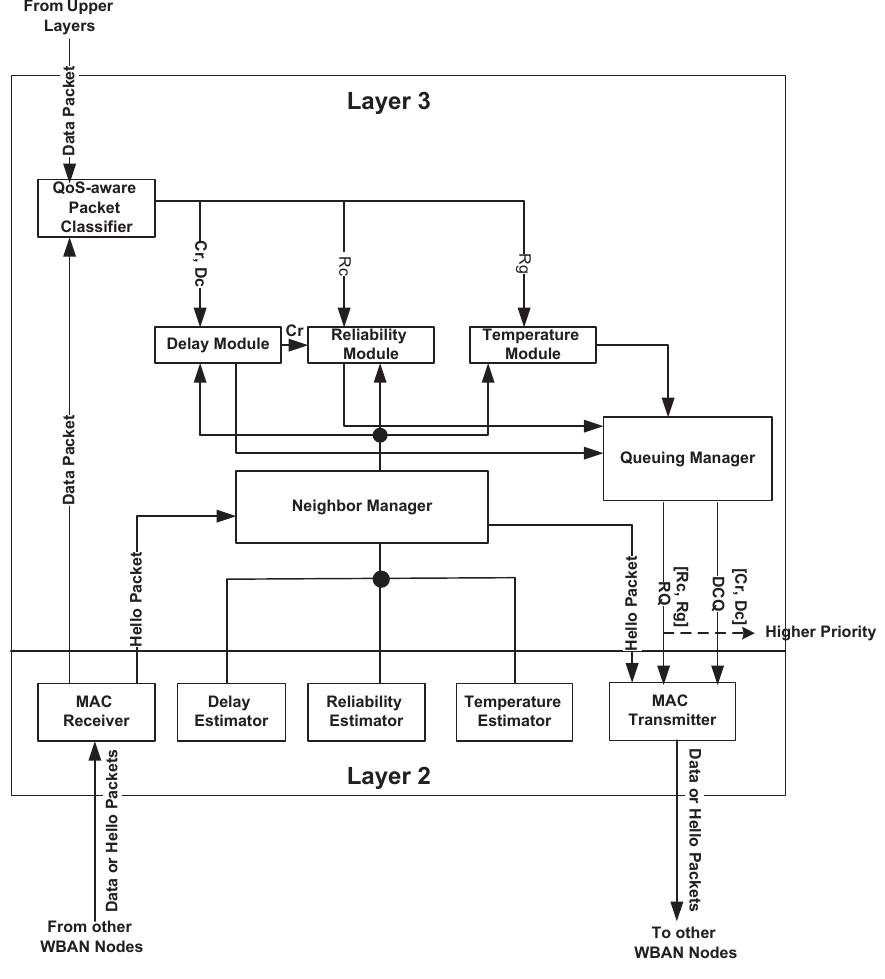
Figure 2. Protocol